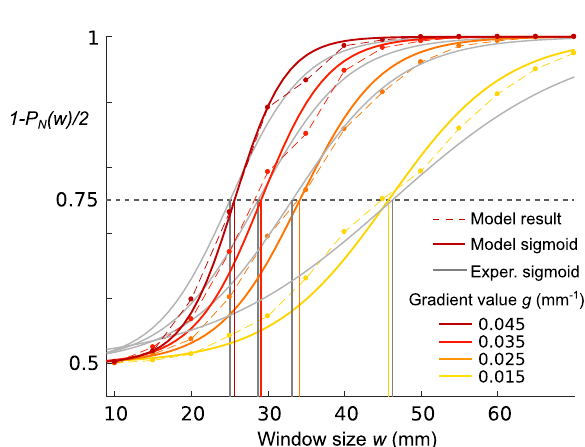
Figure 9. Comparison between the prediction of Model 4 and the experimental results. Probabilities are calculated with σ opt = 1.153 . The probability of perceiving the gradient variation is plotted for window sizes every 5 mm for the 4 gradient value conditions. These data are fitted by sigmoid curves to find the window size thresholds predicted by the model. Thresholds from the experiment are plotted in